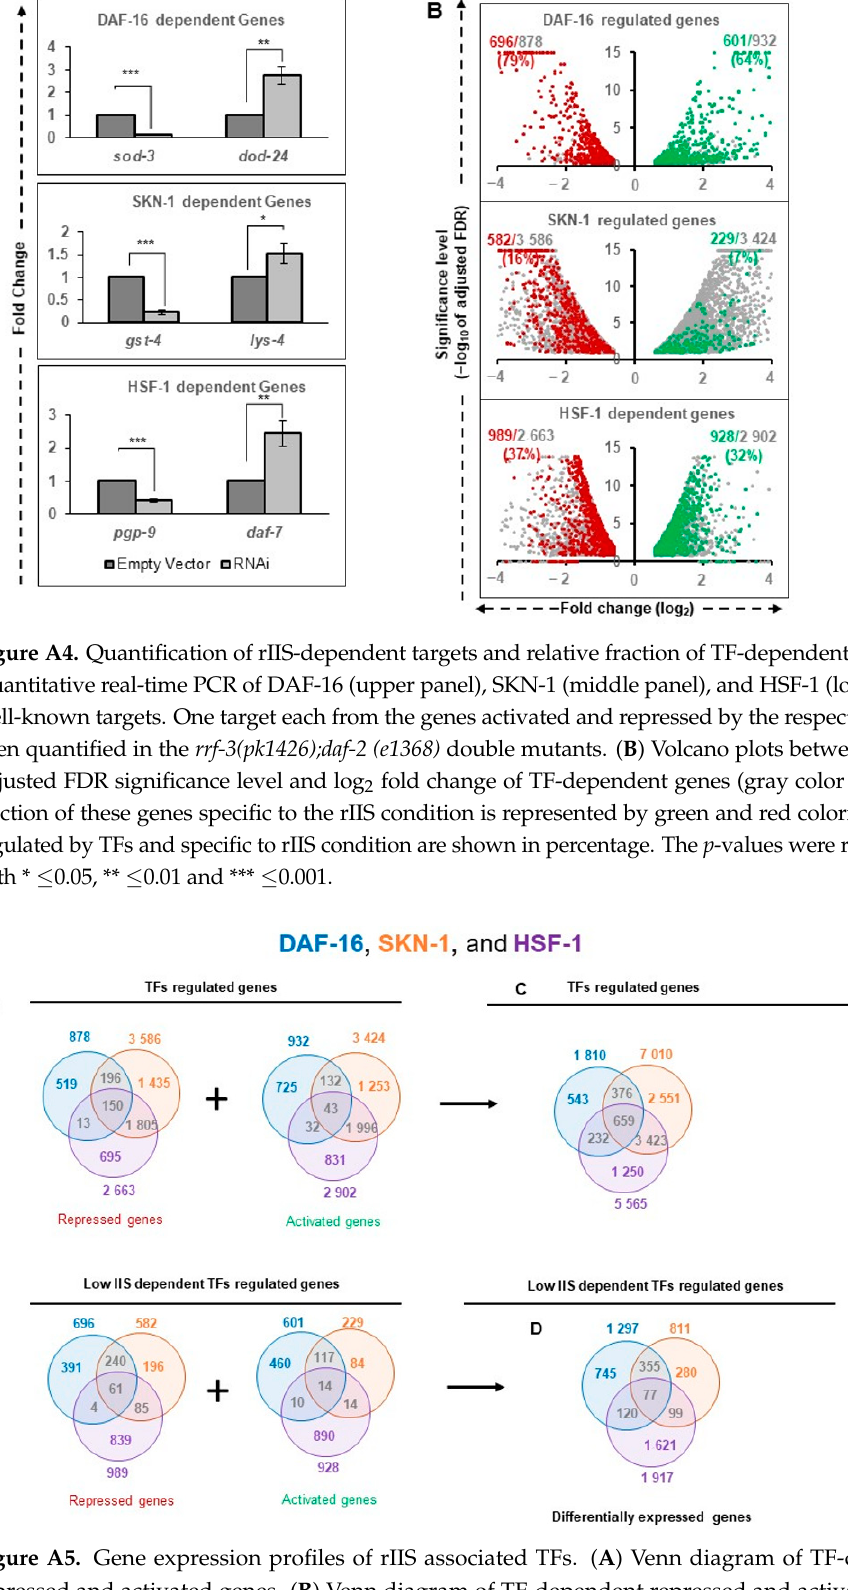
Figure A3. Reduced IIS condition-dependent gene comparison with earlier datasets. Venn diagrams represent the overlap with earlier published datasets. Differentially expressed genes were considered together to compare with earlier published